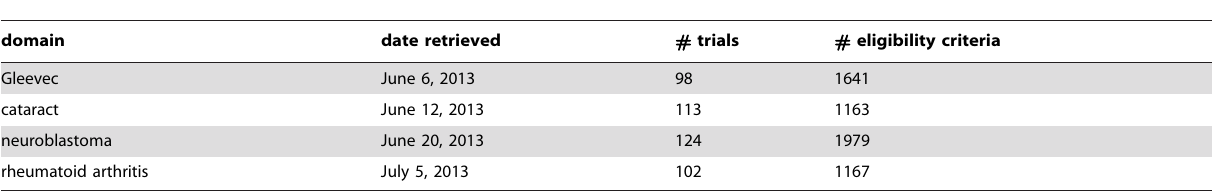
Table 1. Number of trials and eligibility criteria.